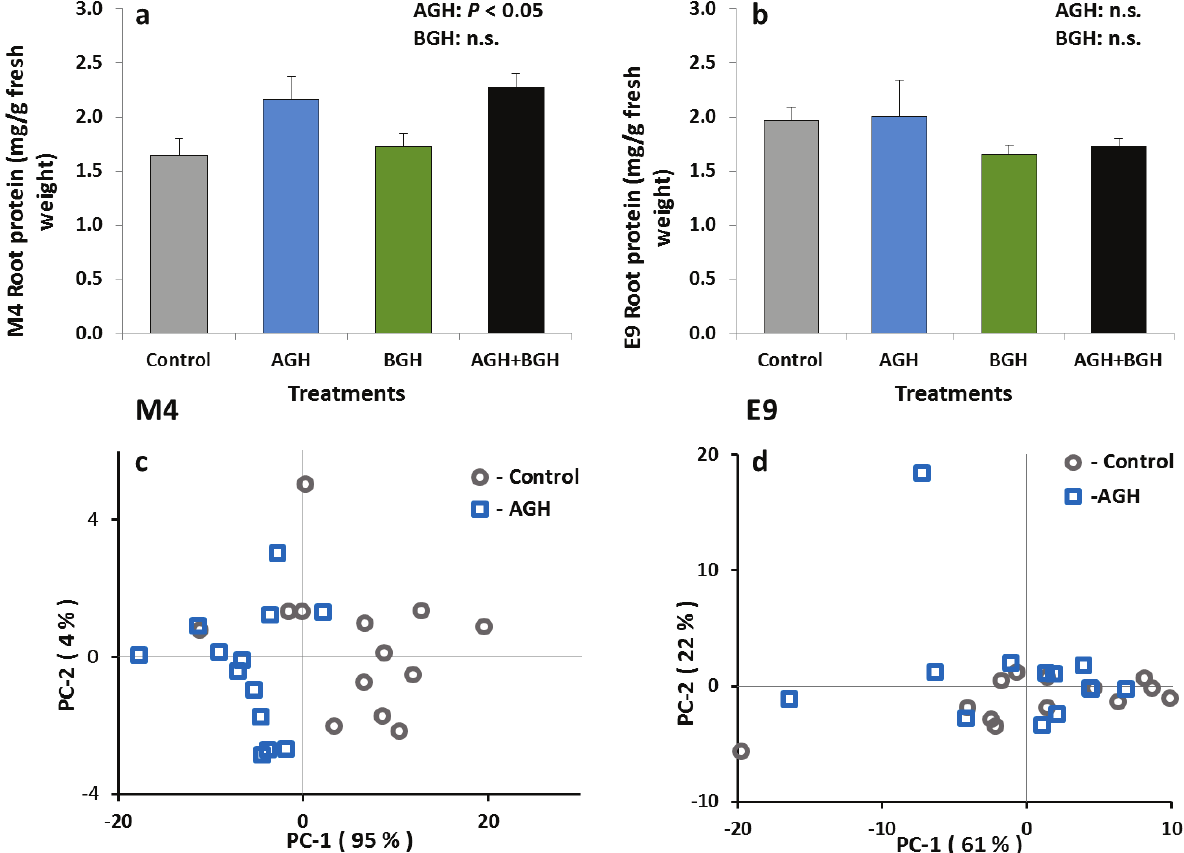
Figure 3. Total protein content (mg/g fresh weight) in the root tissue of the genotype M4 ( a ) and E9 ( b ) (mean ± SE) and results from PCA of the FT-IR spectra of the root material from M4 ( c ) and E9 ( d ) (spectral ranges of 1680 – 1620 cm − 1 and 1550 – 1500 cm − 1 . Spectra are treated by vector normalization). Treatments: control, AGH: aboveground herbivory only, BGH: belowground herbivory only and AGH+BGH: aboveground herbivory followed by belowground herbivory with the lag phase of seven